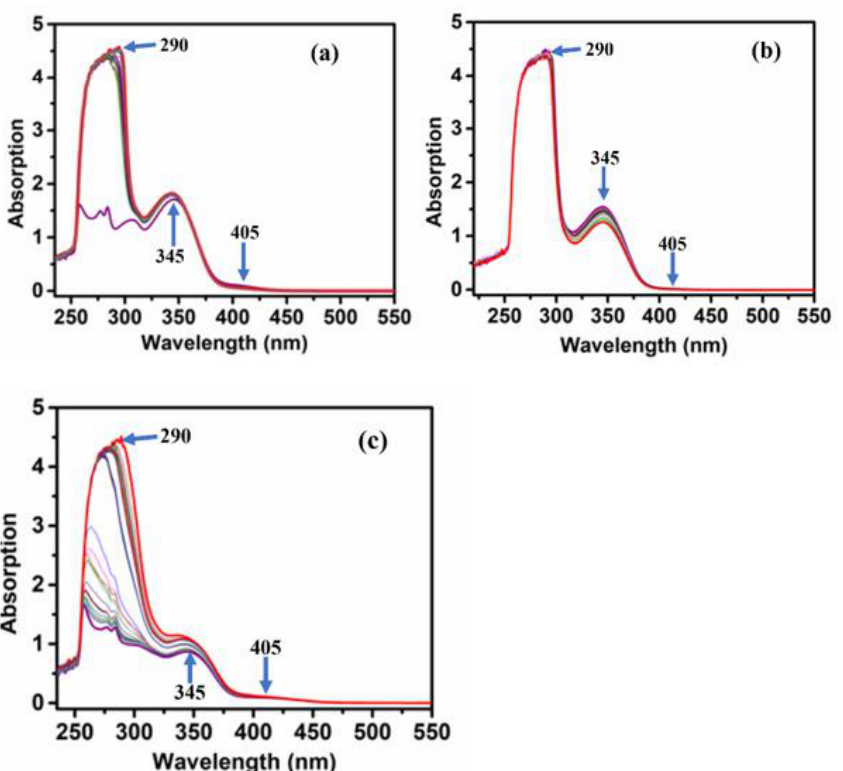
Figure 23. ( a ) Spectral changes observed after successive addition of a one-drop portion of benzaldehyde (9.4 × 10 − 3 M) dissolved in 10 mL of DMSO into a 10 mL DMSO solution of complex ( 1 ) (8.66 × 10 − 5 M) for every 2 min interval. ( b ) Spectral changes observed after the successive addition of a one-drop portion of ammonium acetate dissolved in 10 mL of DMSO (1.29 × 10 − 2 M) to a solution of ( a , c ) Spectral changes observed after the successive addition of a one-drop portion of benzil (9.52 × 10 − 3 M) to the solution of complex 1 for every 2 min interval.